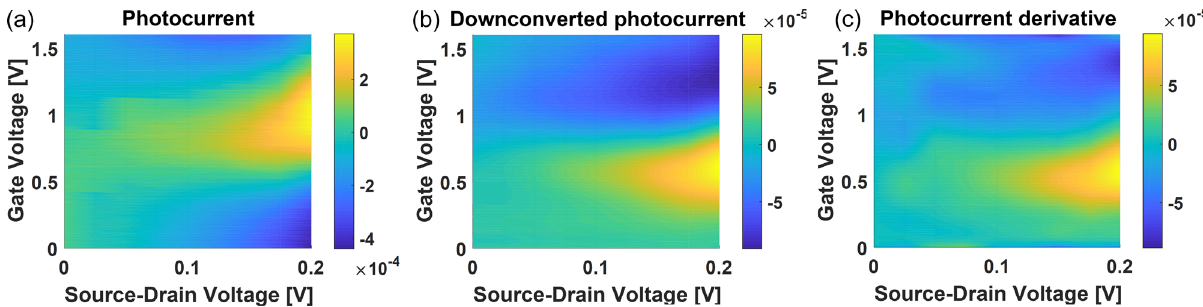
Fig. 5 V GS – V DS maps. a Photocurrent map as a function of V GS , V DS . b Downconverted photocurrent map as a function of V GS , V DS . c Derivative of a with respect to V GS . The photocurrent values are in mA.